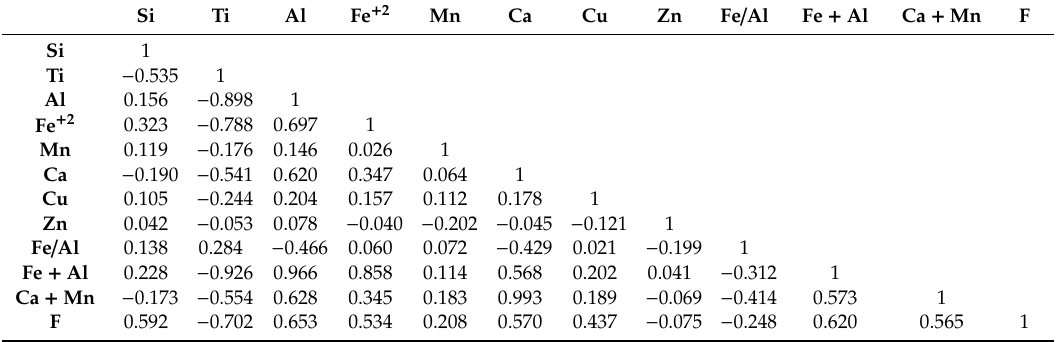
Table A1. Correlation matrix of titanite compositions from mineralized zones.